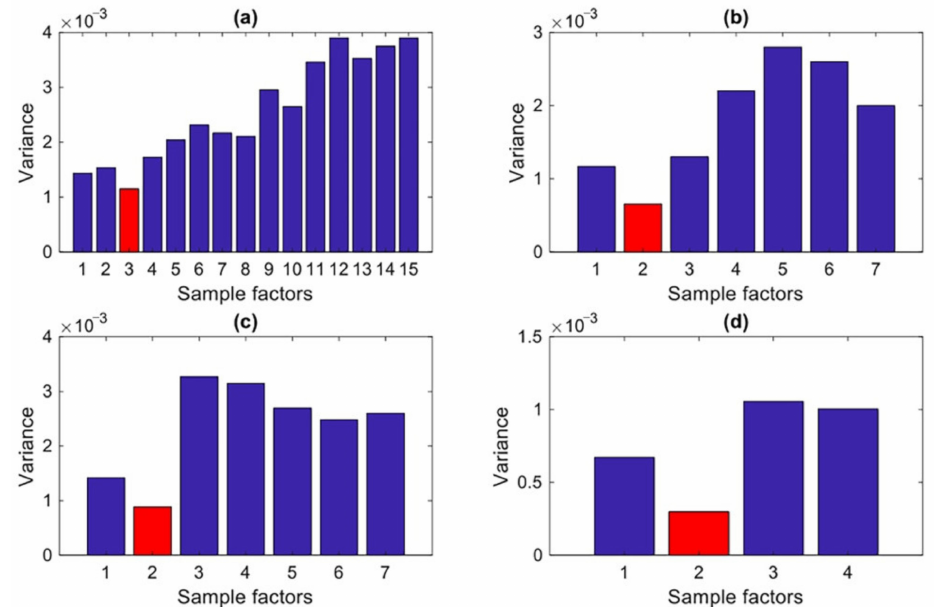
Figure 6. Determination of the number of factors needed for the SFA algorithm: ( a ) Case 1, ( b ) Case 2, ( c ) Case 3, ( d ) Case